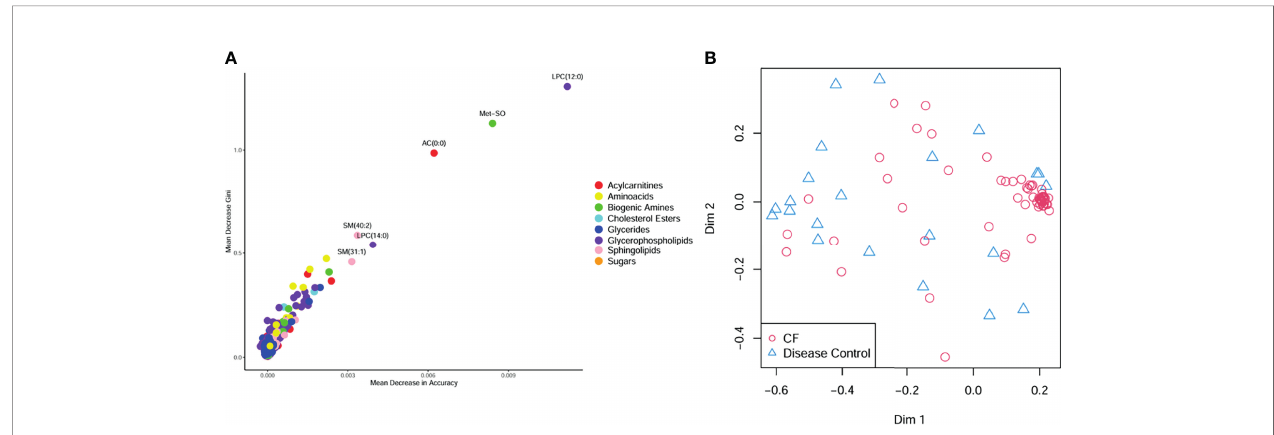
scaling (MDS) plot from the proximity matrix indicate a lack of separation between PWCF and DC subjects for about one-third of the CF samples, the remaining CF samples are grouped in a distinct cluster ( Figure 2B ).